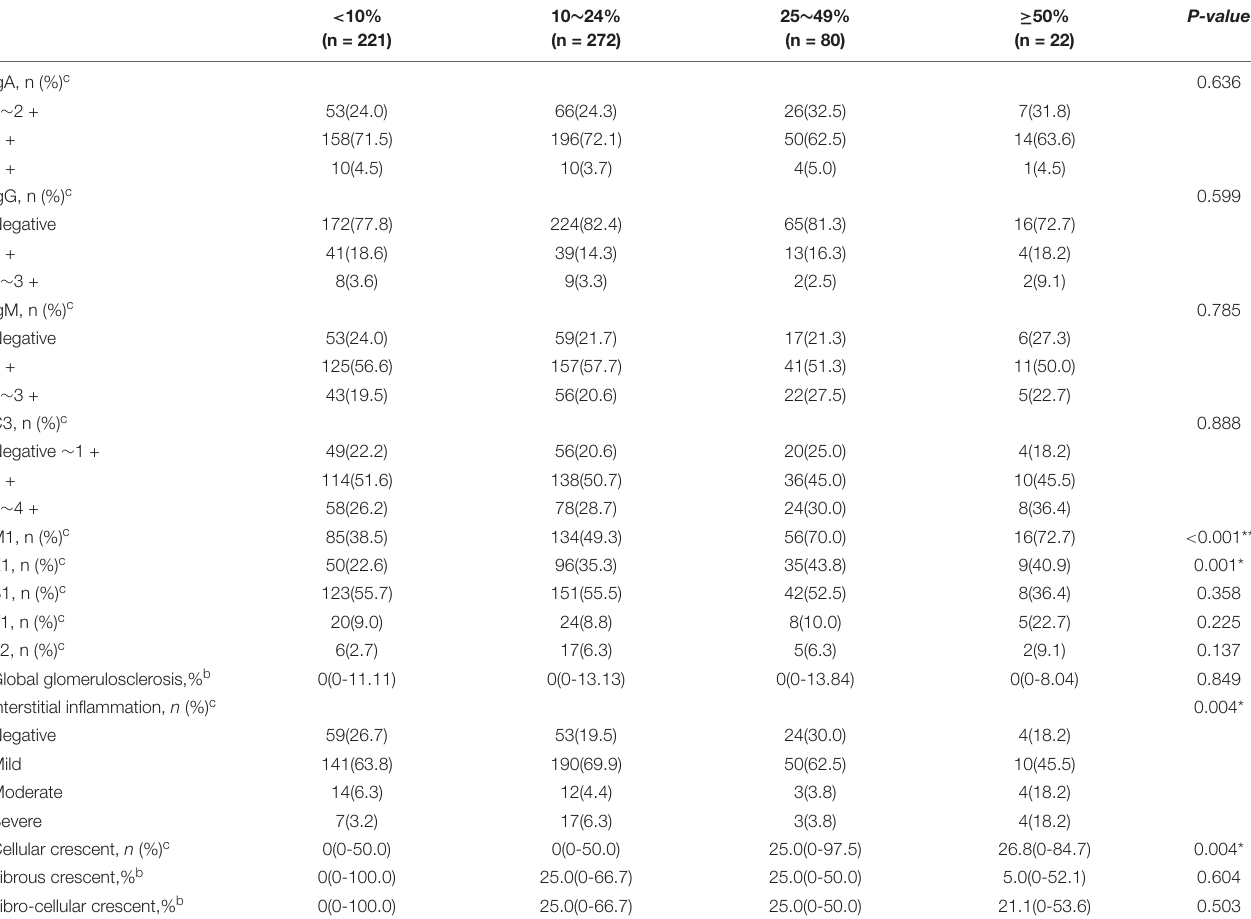
TABLE 2 | Pathological characteristics of IgAN patients with different proportions of crescents.